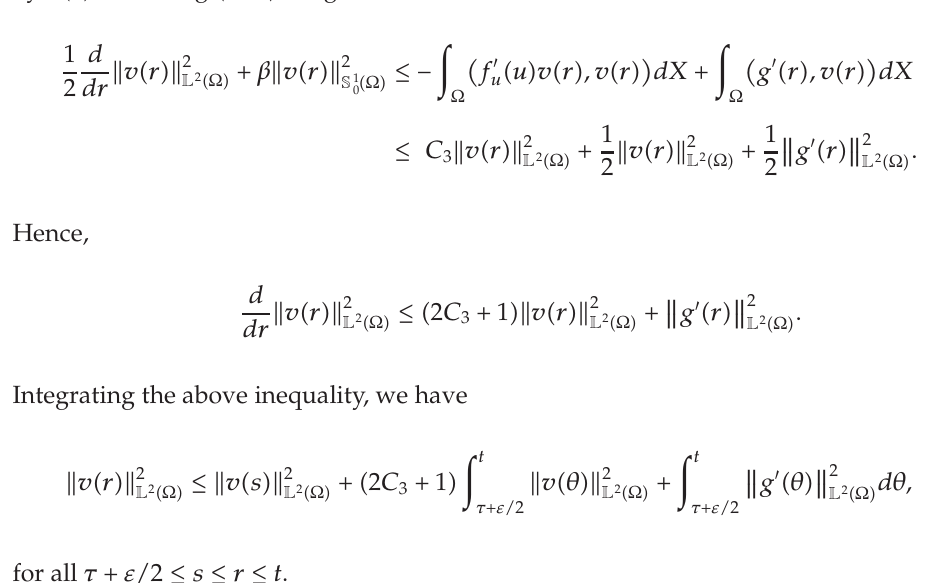
Di ff erentiating the first equation in (cid:2) 1.2 (cid:4) in time t and setting v (cid:2) r (cid:4) (cid:8) u (cid:9) (cid:2) r (cid:4) , then multiplying by v (cid:2) r (cid:4) and using (cid:2) 1.11 (cid:4) we